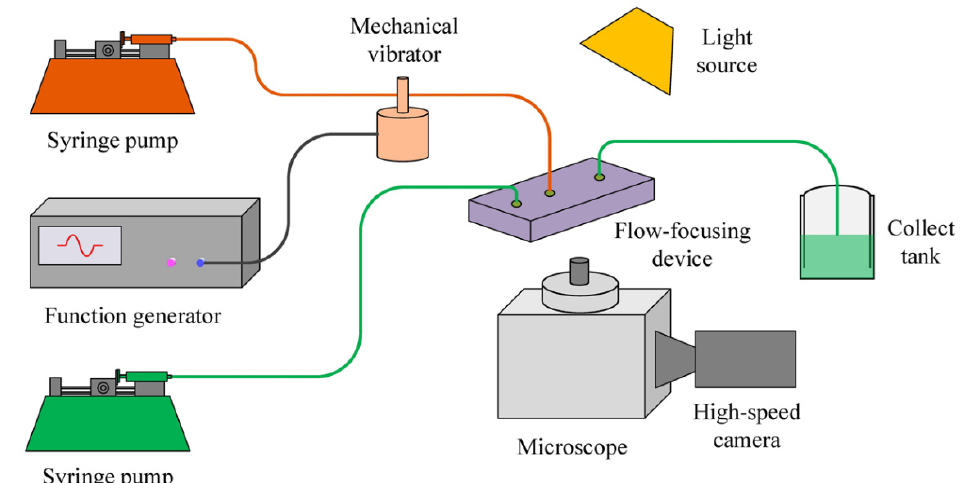
Figure 1. Schematic diagram of experimental setup for droplet generation in flow-focusing microfluidic chip with external mechanical vibration.